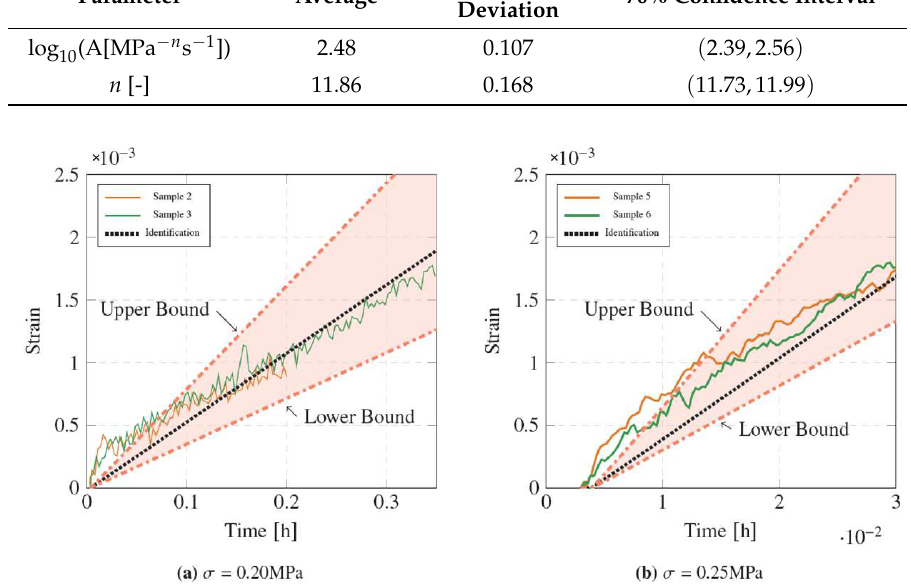
Figure 8. Compressive creep identification results at T = 1300 ◦ C—Reduced number of samples. Table 4. Results of the inverse identification—Tensile creep—Reduced number of samples. Parameter